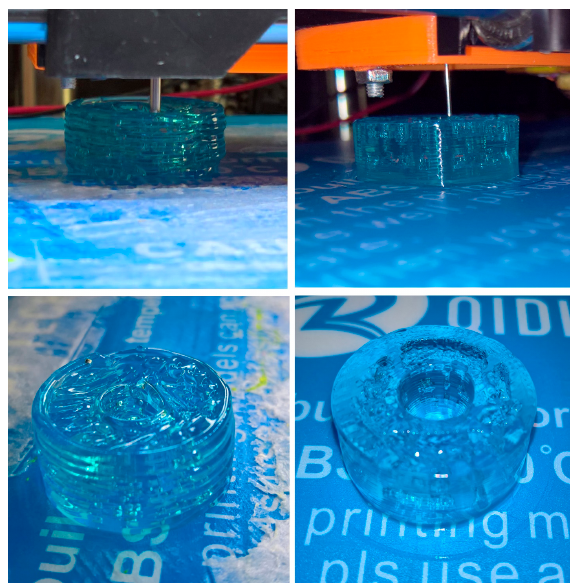
Figure 14. Same part fabricated out of dental gel using two different nozzles and layer heights ( Left ) 1.2 mm nozzle with 0.8 mm layer height ( Right ) 0.4 mm nozzle with 0.25 mm layer height.